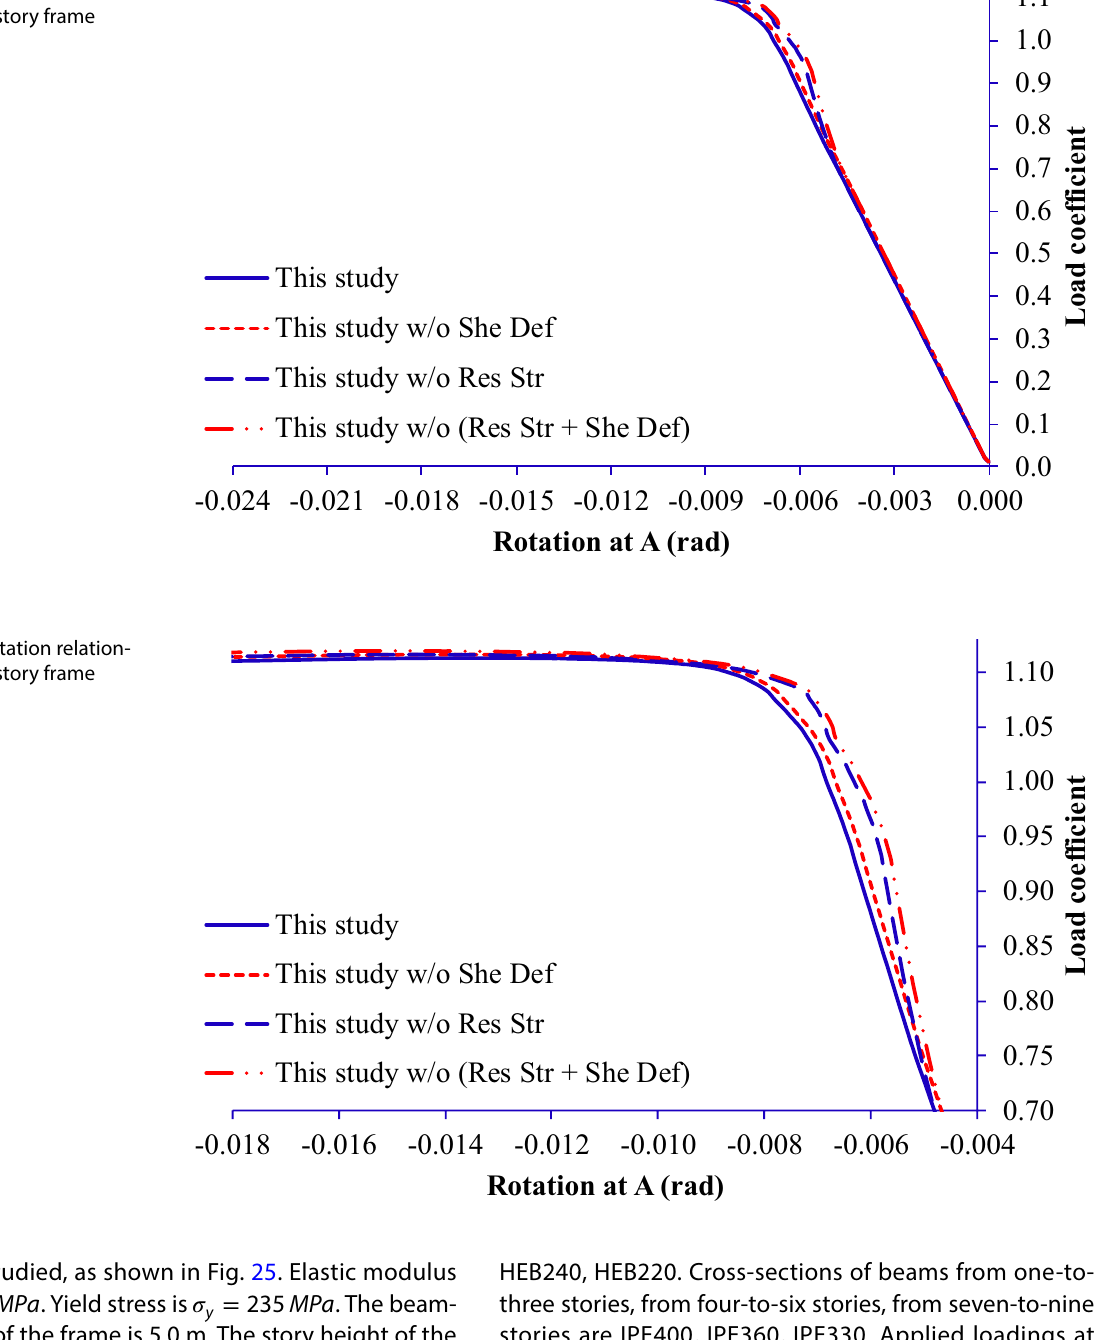
Fig. 25. We use one element per member for modeling all beam-columns for the frame. All cross-sections are divided